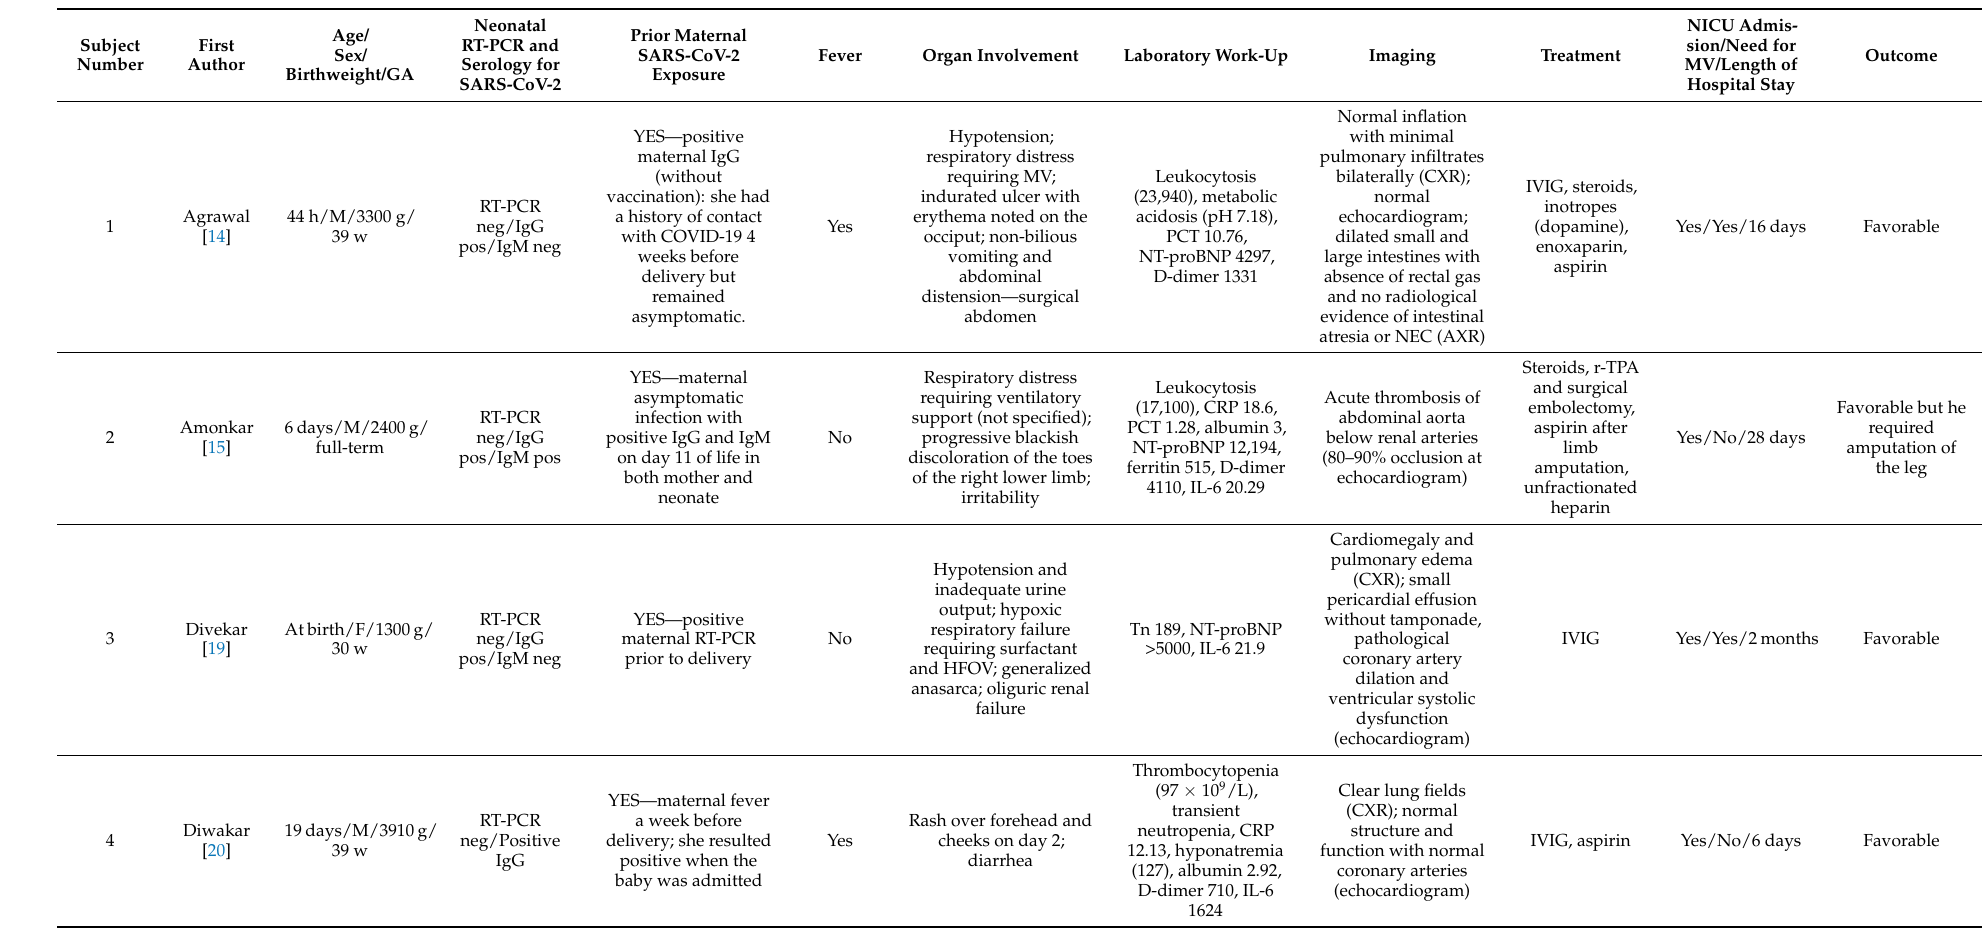
Table 2. Characteristics of neonates with MIS-N with fully described